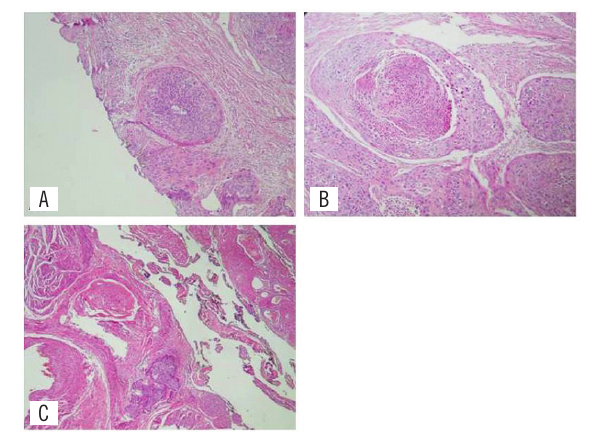
figurE 3 − Histopathology showing keratinizing squamous cell carcinoma mildly- differentiated A) compromised limit; B) keratinization; C) parametrial